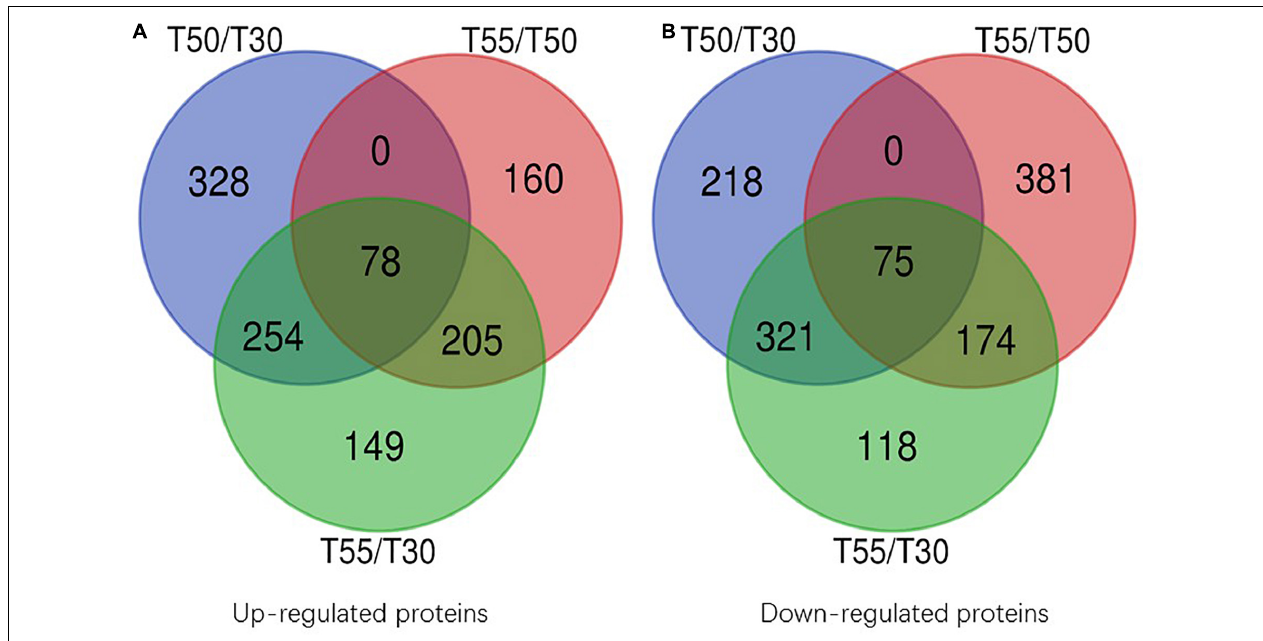
FIGURE 7 | Venn diagram of differentially expressed proteins. (A) Venn diagram of up-regulated proteins. (B) Venn diagram of down-regulated